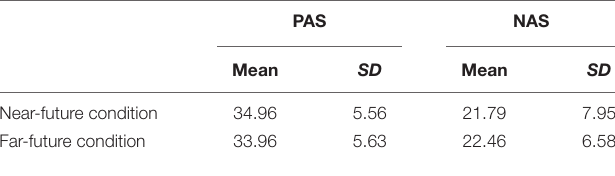
TABLE 1 | Positive and negative affect scores by